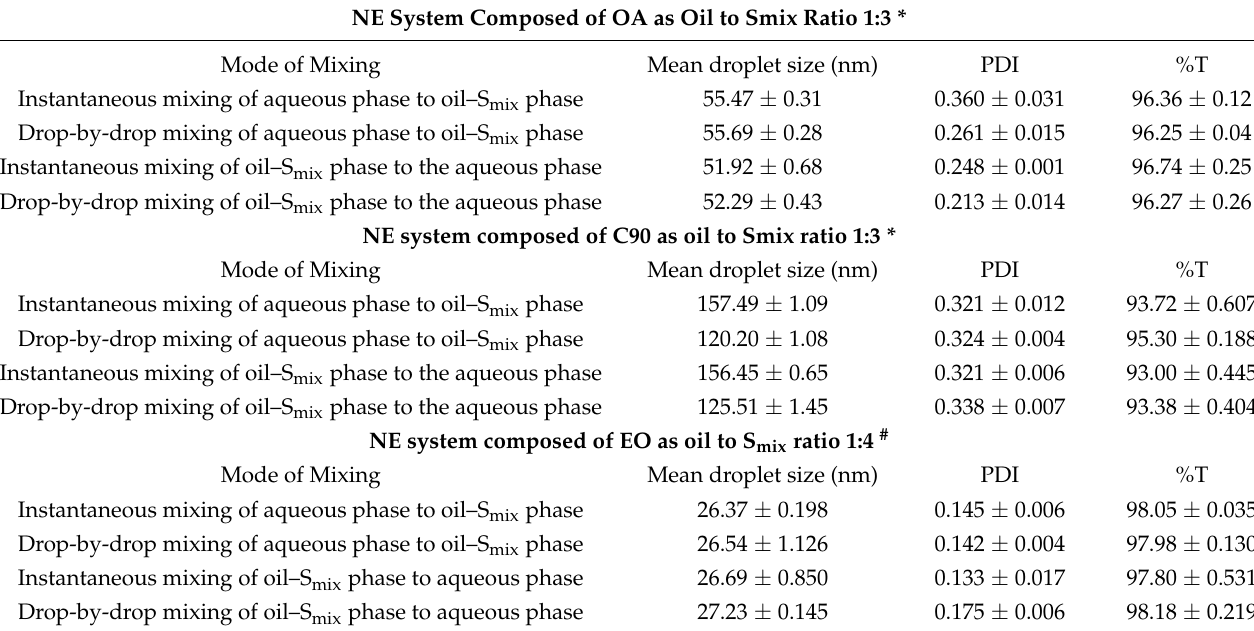
Table 3. Effect of mode of mixing of aqueous phase to Oil–S mix phase and vice-versa on OA-based, C90-based, and EO-based NE